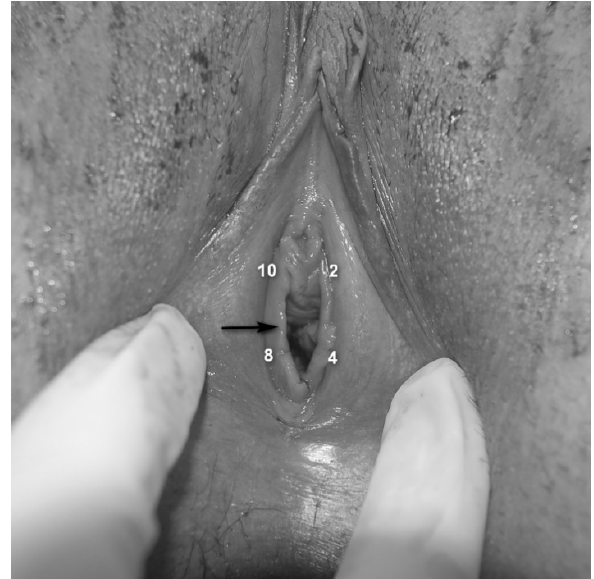
Figure 1. The vulvar vestibule and hymenal ring (black arrow). The assessed vestibular anatomic locations are marked by the numbers 2,4,8 and 10. The hymenal ring is intact albeit previous vaginal penetration and provokes severe pain with a gentle lateral stretching with 2 fingers.